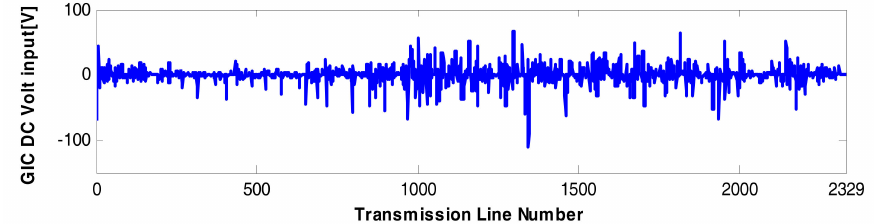
Figure 4. Geomagnetically induced currents (GIC) direct current (DC) volts on the Transmission Line.